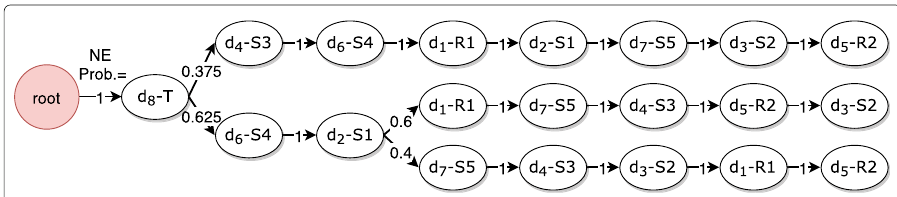
Fig. 5 The decision-support tree for action